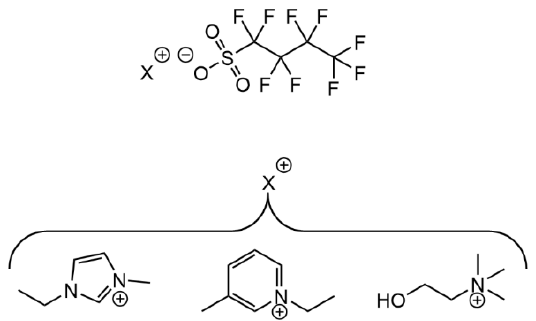
Figure 12. Perfluorobutanesulfonate-based ILs comprising the (from left to right) 1-methyl-3- ethylimidazolium, 1-methyl-3-ethylpyridinium, and cholinium cations, as reported by Vieira et al. [166]. Adapted with permission from ref. [166]. Copyright 2020